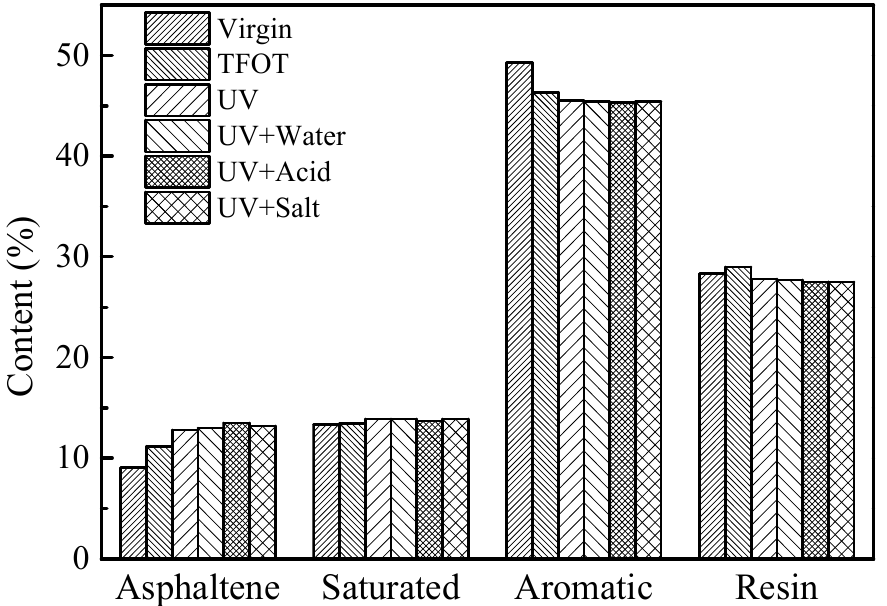
Figure 4. Contents of four components of virgin bitumen before and after UV aging in different environments.